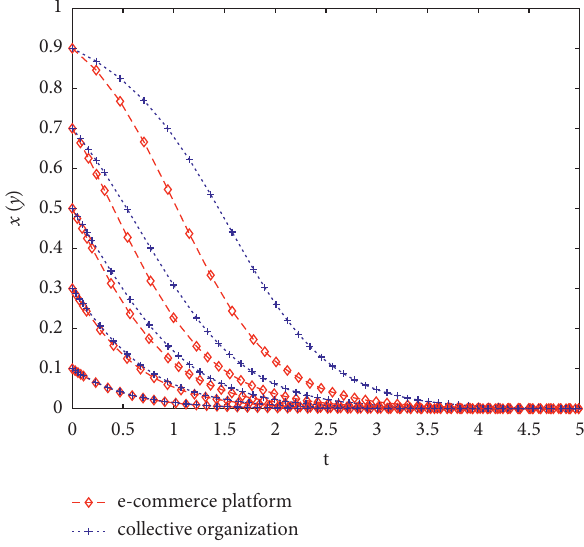
Figure 6: The stability analysis of Model I.